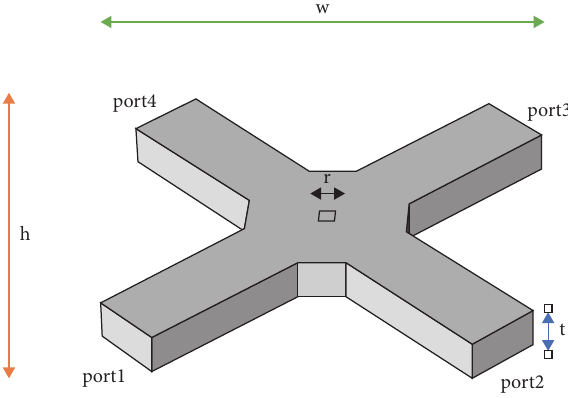
Figure 2: 3D geometry of a four-port